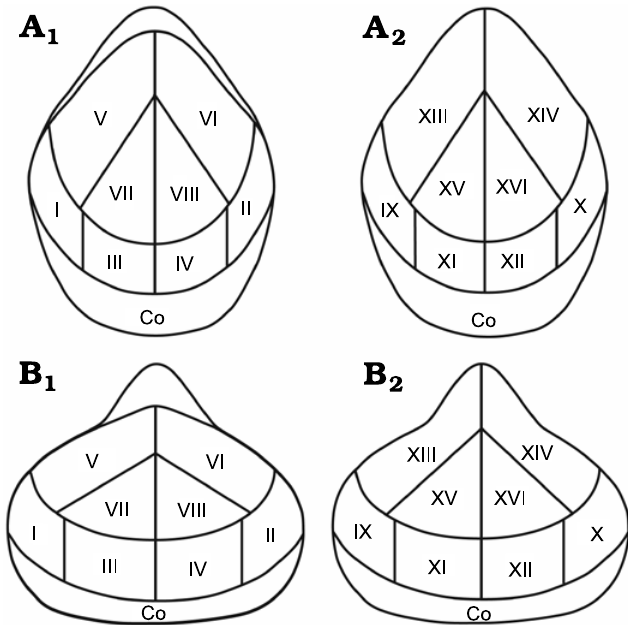
Fig. 2. Sector divisions of hosts for the encrusted abundance and distribu- tional patterns. Athyridids ( A ) and rhynchonellids ( B ), in dorsal (A 1 , B 1 ) and ventral (A 2 , B 2 ) views. Co, commissure.